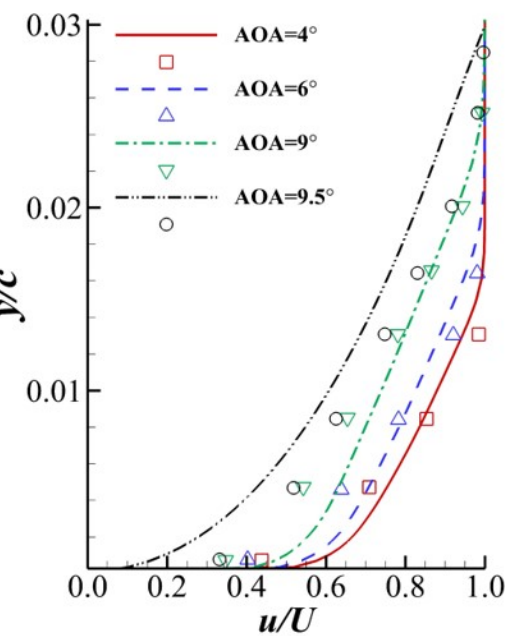
Figure 11. Velocity profiles for Re = 4.1 × 10 6 and Ma = 0.167. The curves represent computational results obtained by the SPF k − v 2 − ω model. The symbols are experimental data by Peterson [34].